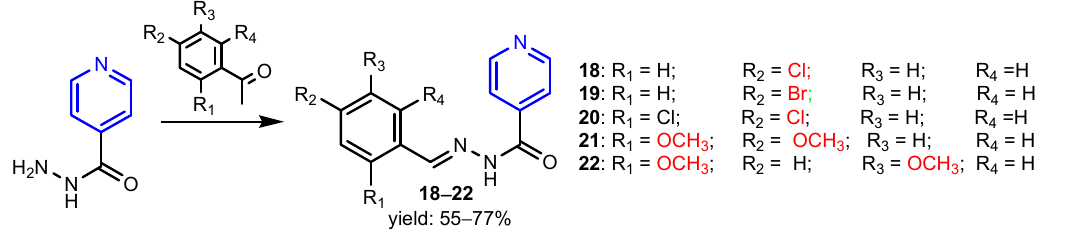
Scheme 4. Synthesis of isonicotinic acid-1-(substituted phenyl)-ethylidene hydrazides 18 − 22 [17]. In a similar study, Judge et al. [18] synthesized a series of isonicotinic acid hydrazide derivatives by benzoilation of ( E )-N’-benzylideneisonicotinohydrazide compounds (Scheme 5) and found that derivatives 23 − 27 were the most active antimicrobial agents against the tested strains S. aureus , B. subtilis , E. coli , C. albicans , and A. niger , with MIC between 2.18 − 3.08 µM mL − 1 . Eldeab [19] synthesized substituted pyridyl-4-chloro benzo- ates by microwave-assisted condensation of 2-oxo-1,2-dihydropyridine-3- carbonitriles with 4-chlorobenzoyl chloride under solvent-free conditions or by conventional heating in methylene chloride in the presence of triethylamine. The activity of 3-cyano-5-[(4-hy- droxyphenyl)diazenyl]-4-methyl-6-phenylpyridin-2-yl-4-chloro benzoate 28 against B. subtilis and S. aureus was comparable to that of Amikacin, which is used as the standard antibiotic (Figure 2). Karunanidhi et al. [20] isolated 2-(methyldithio)pyridine-3-